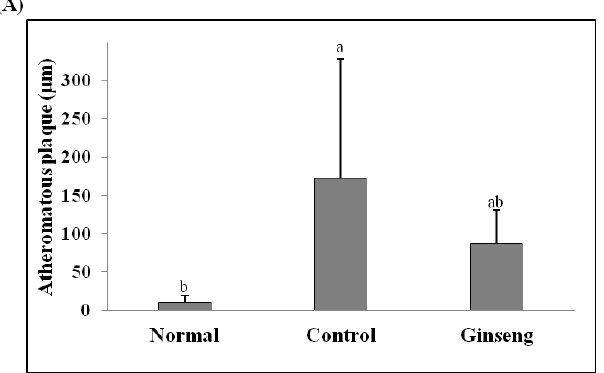
Figure 3. Atheromatous plaque ( A ) and Media thickness ( B ) in the rabbits fed the experimental diets. All values are mean ± SD for 7 rabbits. Values with different letters are significantly different by ANOVA with Duncan’s multiple range test at p < 0.05. Normal diet; Control, high cholesterol diet; Ginseng, high-cholesterol diet containing 0.05% white ginseng low-molecule